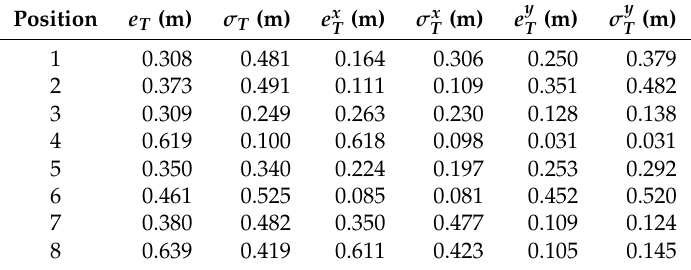
Table 6. Measured accuracy of the TSML algorithm in Scenario 3.